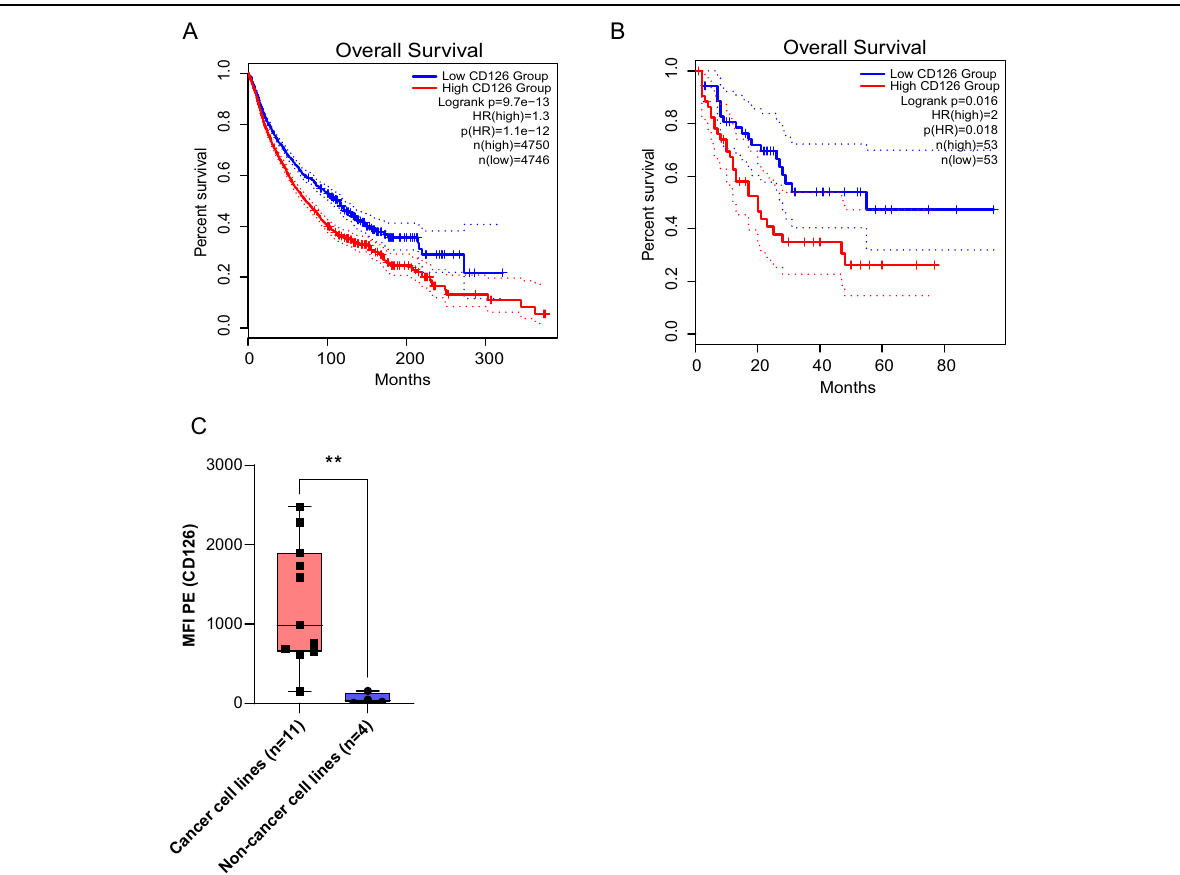
Fig. 1 CD126 is ubiquitously expressed on tumor cells and is a prognostic marker. a Overall survival in various types of cancer ( n = 9496) based on high and low CD126 expression. Median CD126 expression (RNA-sequencing) was used to differentiate CD126 expression. b Overall survival in AML ( n = 106) based on high and low CD126 expression. c MFI CD126 expression in cancer cell lines ( n = 11) compared to non-cancer cell lines ( n = 4). Mann – Whitney U test. ** P < 0.01. Each black square is an individual data